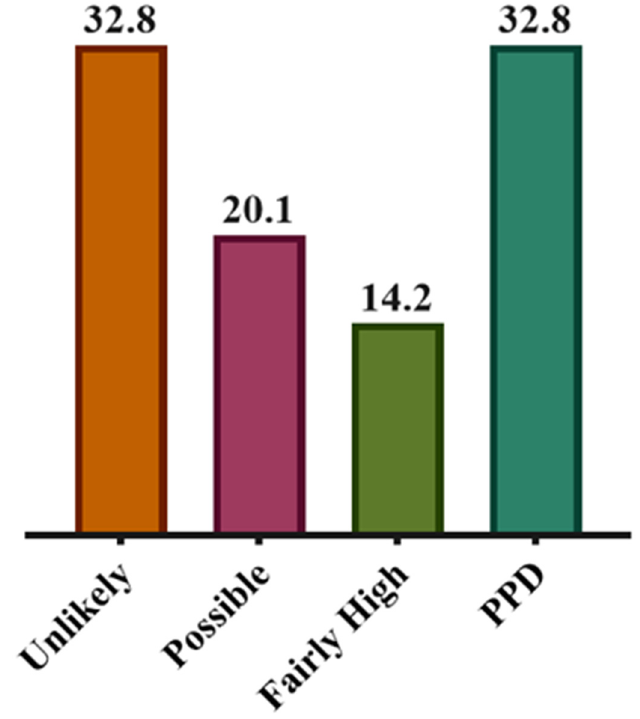
Figure 1. Percentage distribution of likely postpartum depression (PPD) based on EPDS. Table 1. Sociodemographic and clinical characteristics of study subjects.